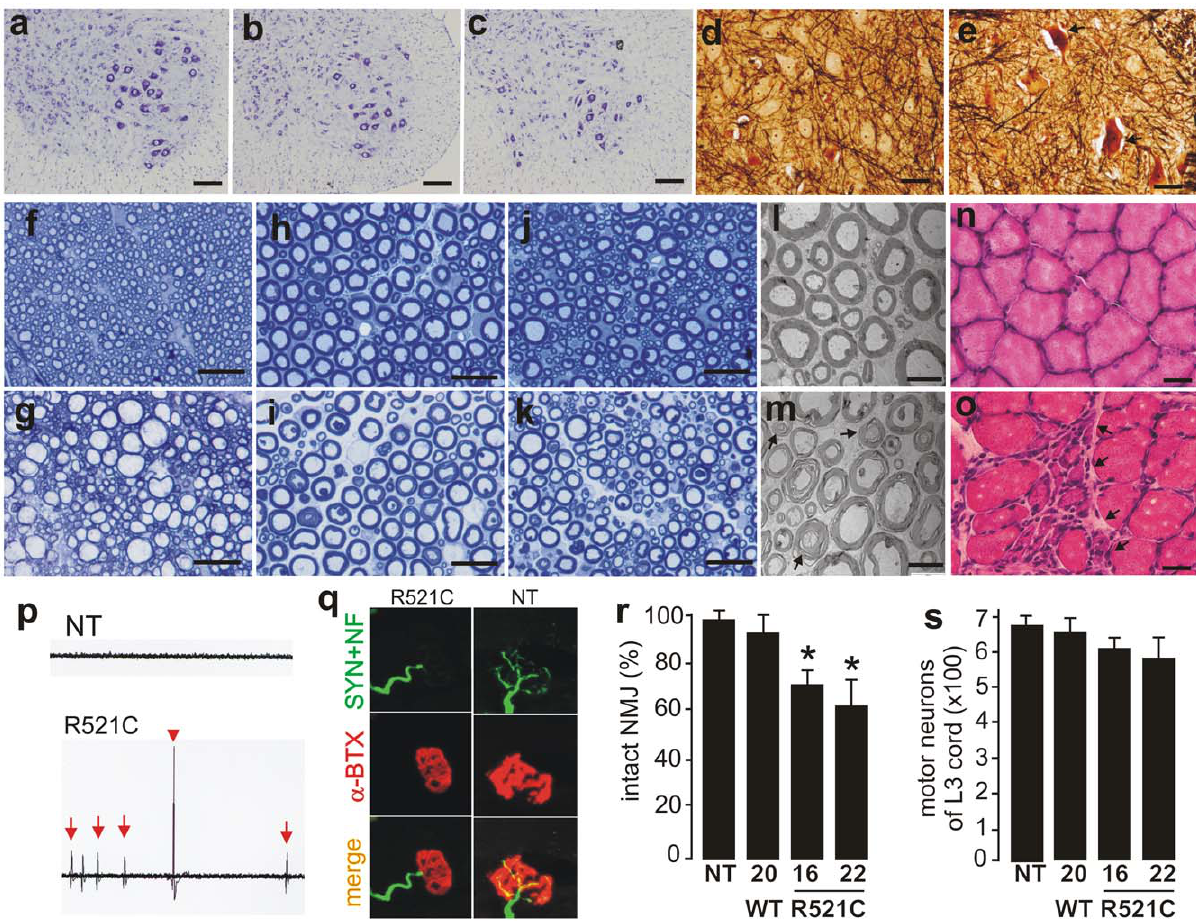
Figure 2. Motor neuron degeneration accompanied by denervation atrophy of skeletal muscle. (A–C) Cresyl violet staining of motor neurons in the L3 ventral horn of mutant FUS transgenic (C, line 16), age-matched nontransgenic (A), and normal FUS transgenic (B, line 20) rats. (D, E) Bielschowsky silver staining detected degenerating neurons (arrows) in the spinal cord of mutant FUS transgenic rats at paralysis stages (E, line 16), but not in that of age-matched normal FUS transgenic rats (D, line 20). Note that degenerating neurons were rare in the mutant FUS transgenic rats even at paralysis stages. (F–K) Toluidine blue staining of axons of the dorsal corticospinal tract (F, G), L3 ventral roots (H, I), and L3 dorsal roots (J, K). Degenerating axons were seen in paralyzed mutant FUS transgenic rats of line 16 (G, I, K), but not in age-matched normal FUS transgenic rats of line 20 (F, G, J). (L, M) Electron microscopy of the motor axons in the L3 ventral roots of paralyzed mutant FUS (M, line 16) and age-matched normal FUS transgenic rats (L, line 20). Arrows point to degenerating axons. (N, O) H&E staining showed group atrophy (arrows) of the gastrocnemius muscle in paralyzed mutant FUS (O), but not in age-matched normal FUS (N) transgenic rats. (P) Electromyography of gastrocnemius muscles revealed fibrillation (arrows) and fasciculation (arrow head) potentials in a mutant FUS transgenic rat (R521C), but not in its nontransgenic littermate (NT). (Q) Confocal microscopy of the focal structures of neuromuscular junctions (NMJ) in gastrocnemius muscles. Compared to the NMJ of a nontransgenic littermate (NT), the NMJ of a mutant FUS transgenic rat (R521C) was denervated. While axon terminals were visualized by immunostaining for synaptophysin (SYN) and neurofilament (NF), postsynaptic nicotinic receptors were visualized with Alexa fluor 555-conjugated a -bungarotoxin ( a - BTX). (R) Quantification of NMJ revealed a reduction of intact NMJ in the mutant FUS (lines 16 and 22), but not in the normal FUS (line 20), transgenic rats. Twenty NMJs were examined for each animal (5-6 rats per genotype). * p , 0.05, transgenic rats vs. nontransgenic rats. (S) Stereological cell counting revealed the number of large neurons ( . 25 m m in diameter) in the ventral horn of L3 spinal segments taken from nontransgenic (NT) or transgenic (TG) rats. Data are presented as means 6 SD ( n =9–11). Scale bars: A–E, 50 m m; F–K, 20 m m; L, M, 5 m m; N, O, 30 m m. ubiquitin aggregation accompanied neurodegeneration. Ubiq- uitin inclusions were detected only in FUS-expressing cells, but were not colocalized with FUS (Figure 4G–4I and Figure 5).